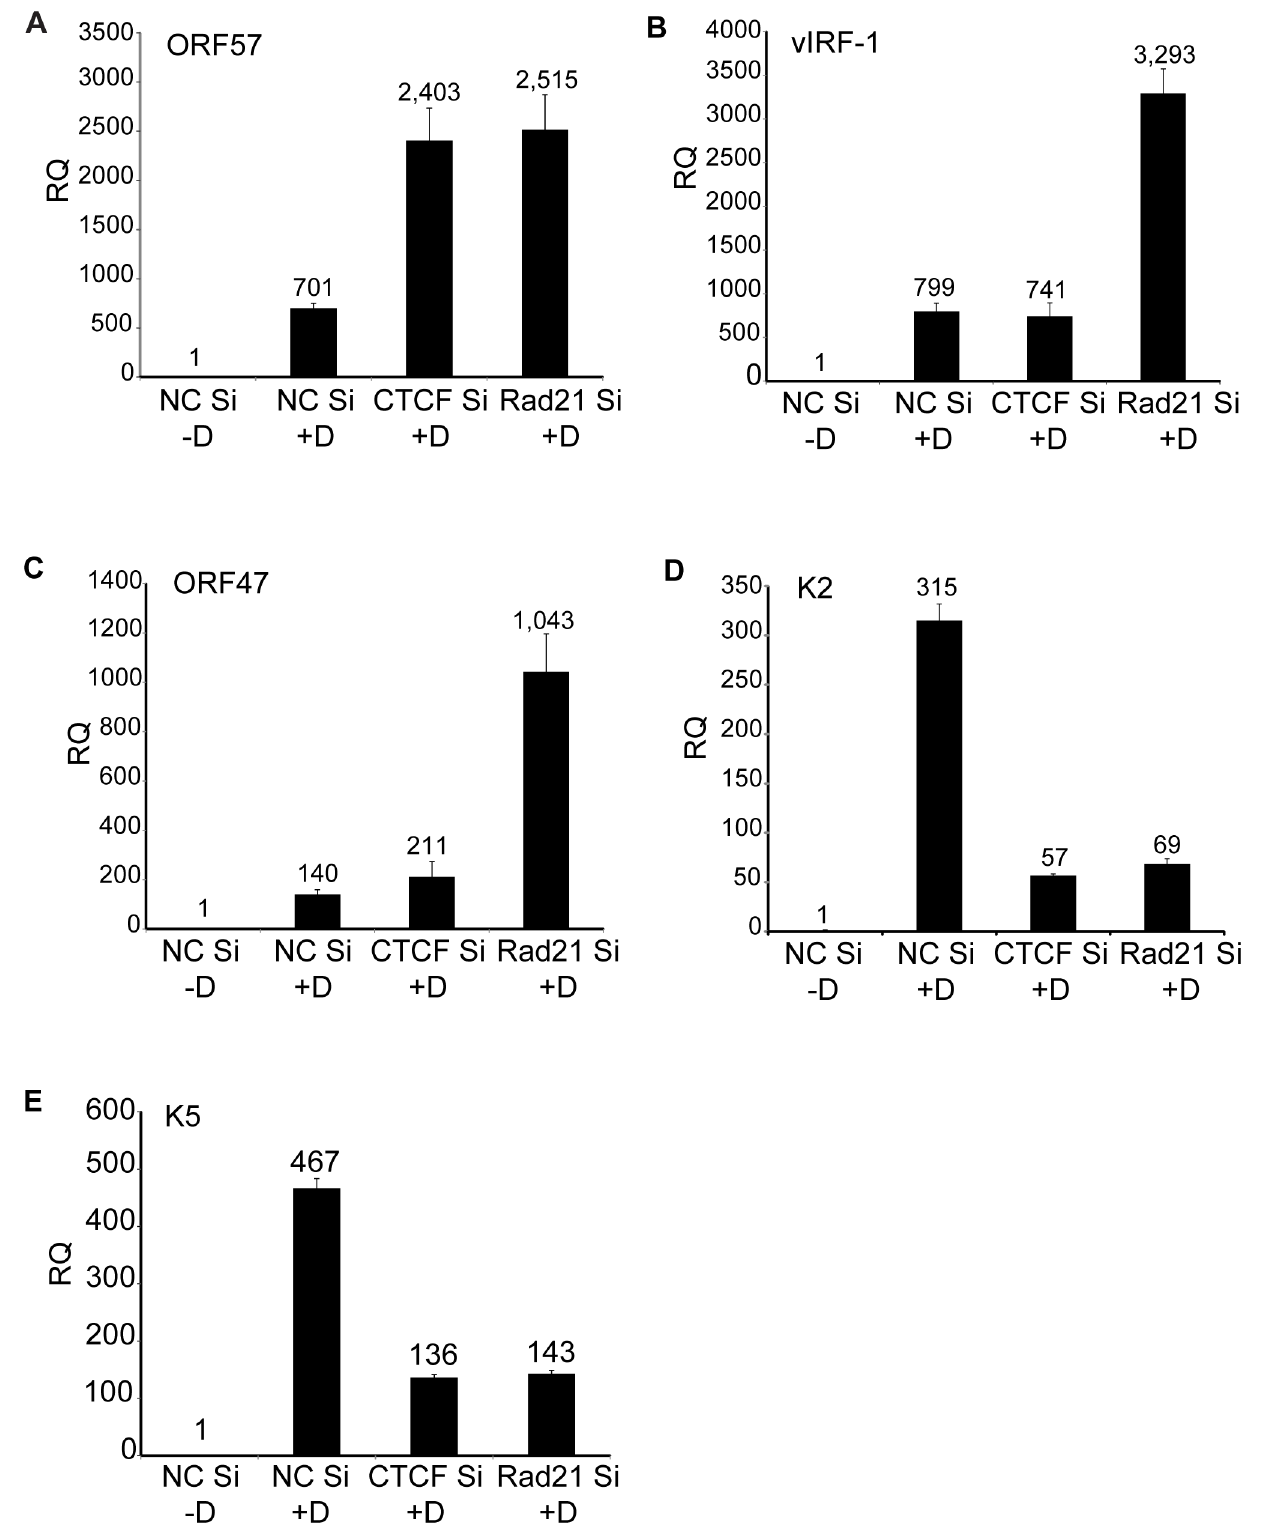
Figure 7. Effects of Rad21 or CTCF knockdown on expression of specific KSHV genes. CTCF or Rad21 knockdown was performed in iSLK cells with siRNAs specific for CTCF (CTCF Si) or Rad21 (Rad21 Si). Cells were also transfected with negative control siRNAs (NC Si). KSHV replication was induced with doxycycline ( + D) or mock-induced ( 2 D), and RNA was harvested 48 h after induction. qPCR was performed with primers specific for ORF57 (A), vIRF-1 (B), ORF47 (C), K2 (D) and K5 (E). Expression of each mRNA (RQ) was normalized to the level of expression in uninduced control cells (NC Si 2 D).